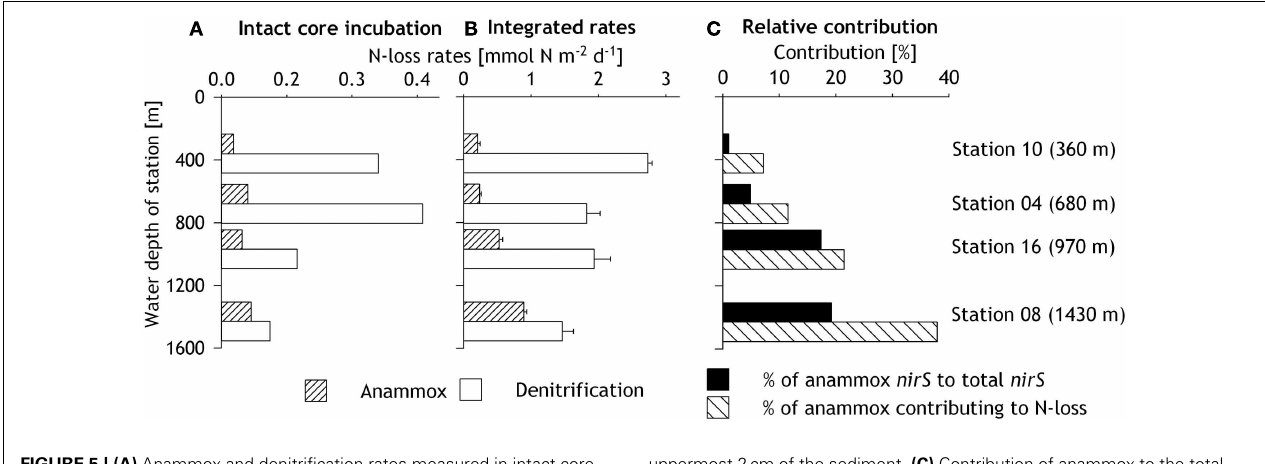
FIGURE 5 | (A) Anammox and denitrification rates measured in intact core incubation experiments, using the rIPT method described by Risgaard-Petersen et al. (2003). (B) Areal depth-integrated rates of anammox and denitrification measured in slurry incubations for the